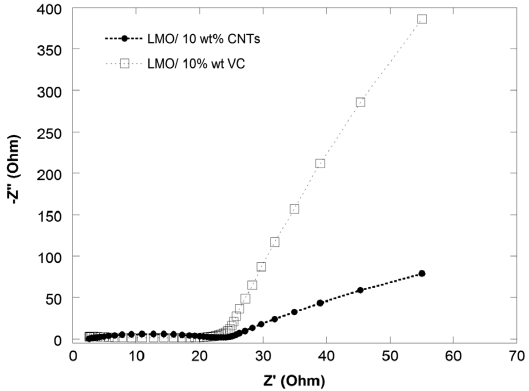
Figure 11. Nyquist plot of LMO/CNTs (10 wt%) nanocomposites (● plot) and LMO/Vulcan Carbon (10 wt%) (□ plot) composites electrode at room temperature.